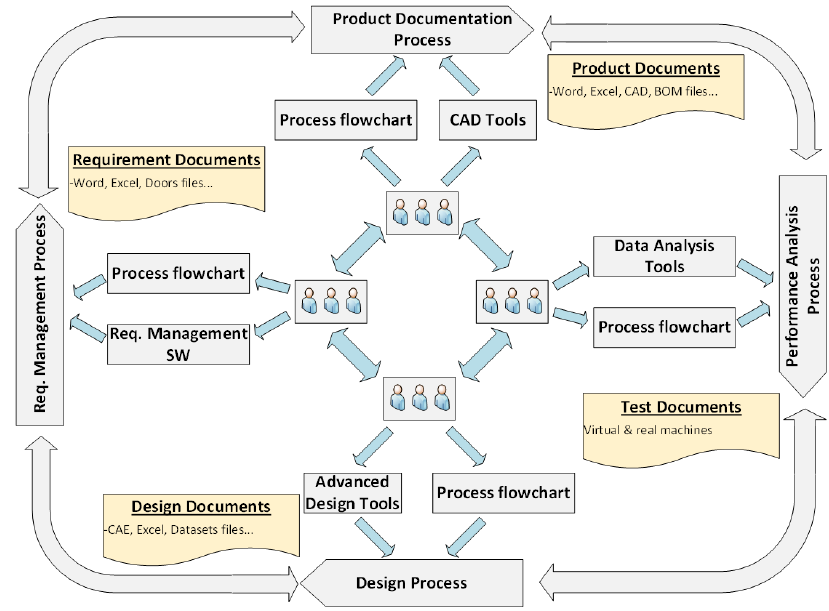
Figure 1. Standardized process for the electric machine design.